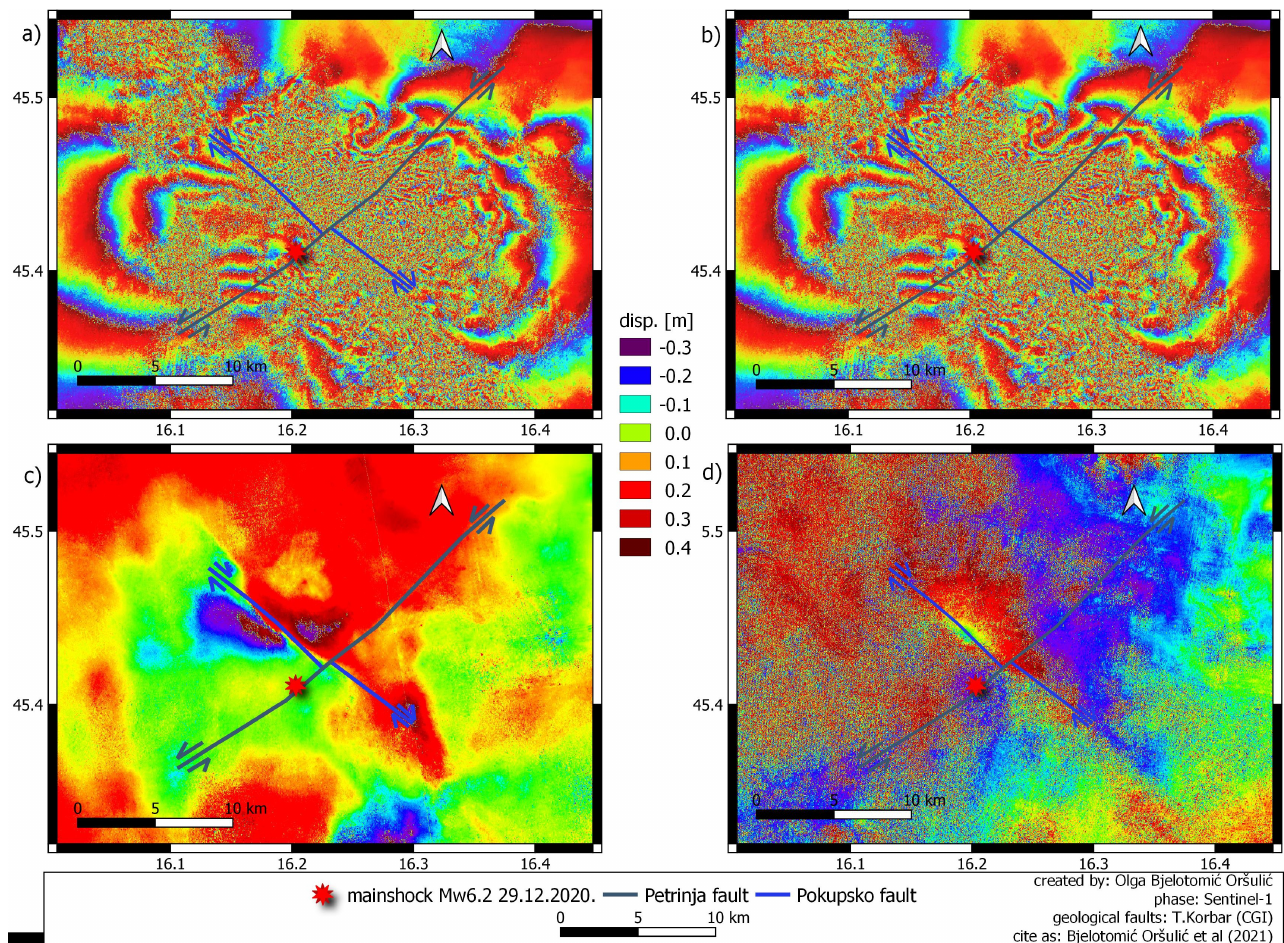
Figure 5. Figure shows interferograms over the earthquake area in NW Croatia: from the ascending orbit of Sentinel-1A ( left ) and descending orbit of Sentinel-1B satellite ( right